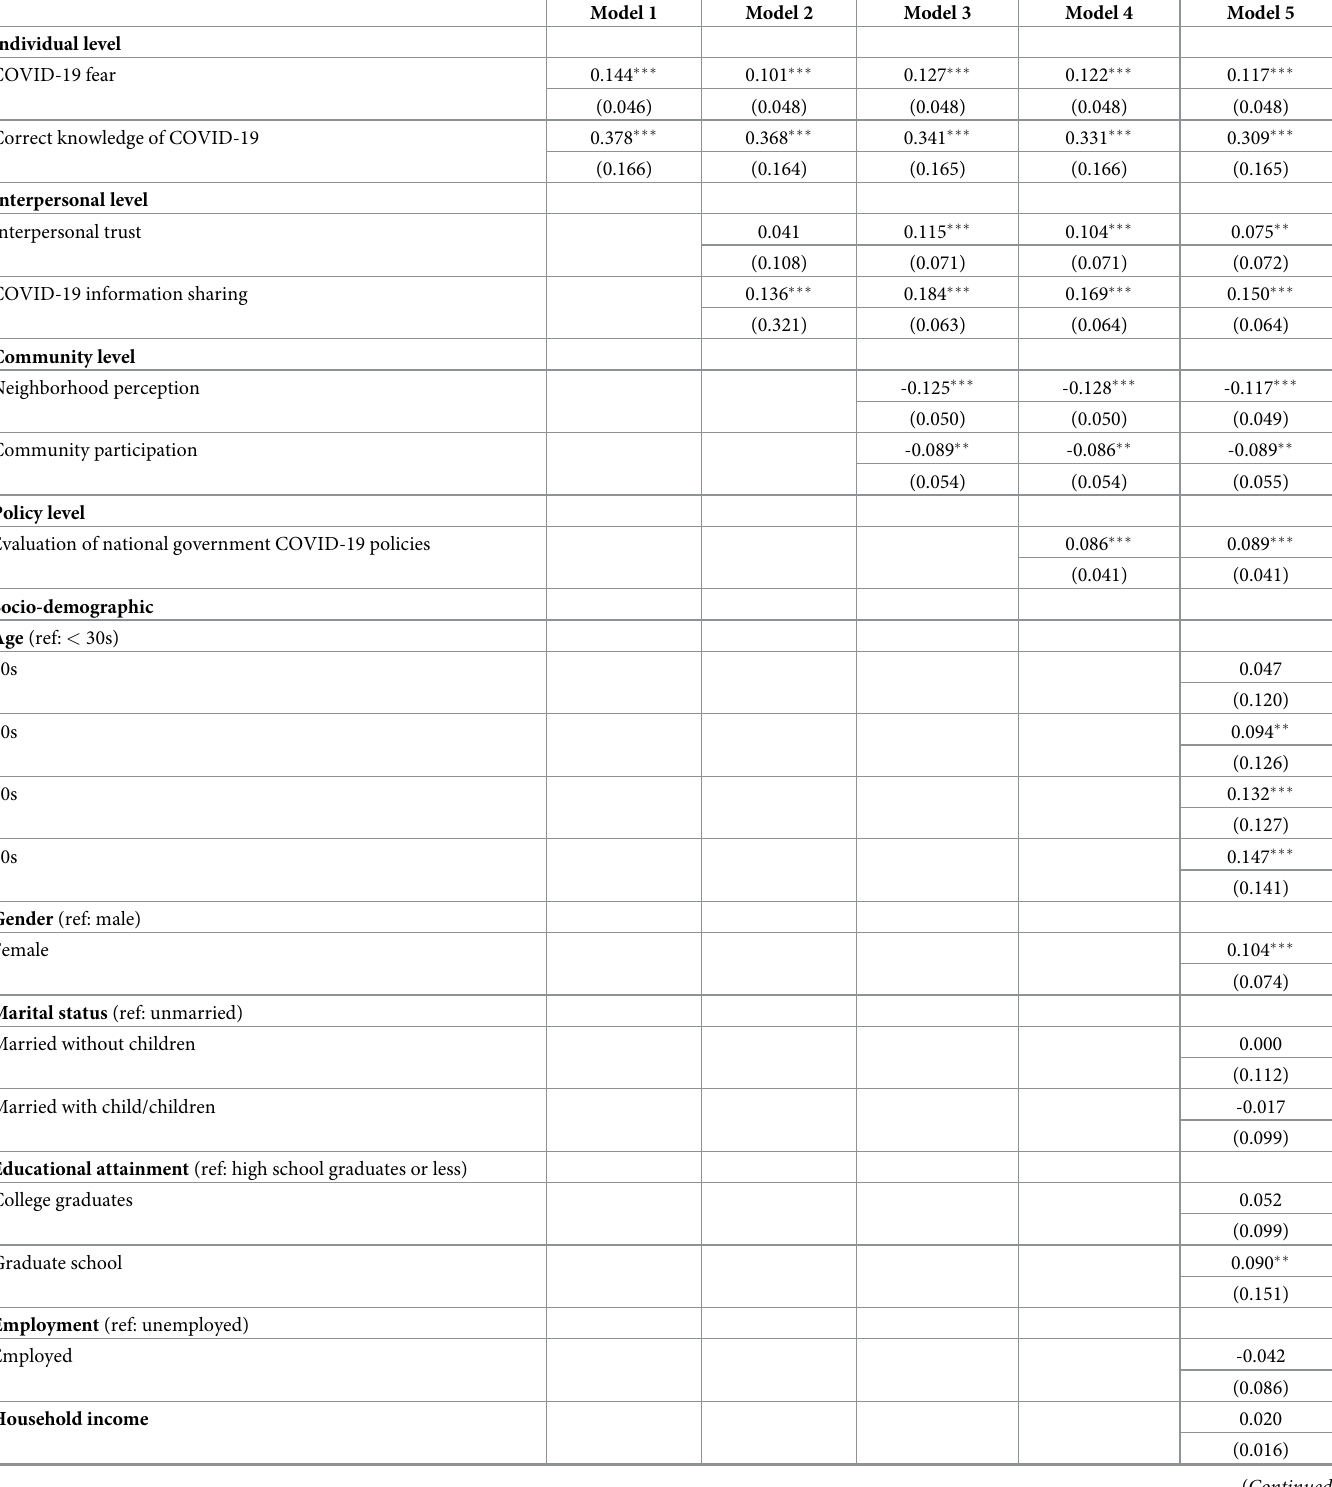
Table 3. Social-ecological factors predicting overall COVID-19 preventive behaviors (N =